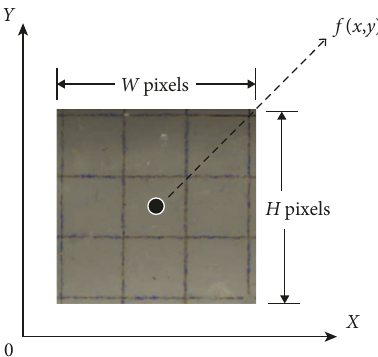
Figure 5: A digital image with W